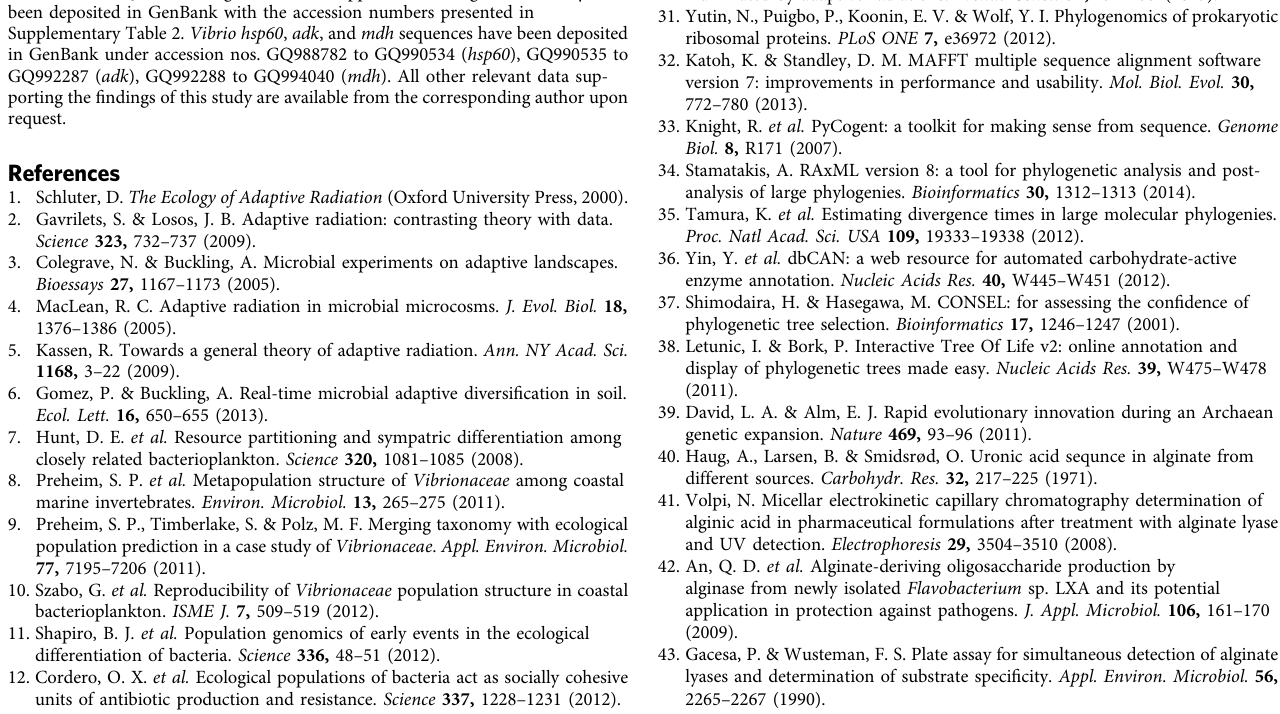
Supplementary Table 2. Vibrio hsp60 , adk , and mdh sequences have been deposited in GenBank under accession nos. GQ988782 to GQ990534 ( hsp60 ), GQ990535 to GQ992287 ( adk ), GQ992288 to GQ994040 ( mdh ). All other relevant data sup- porting the findings of this study are available from the corresponding author